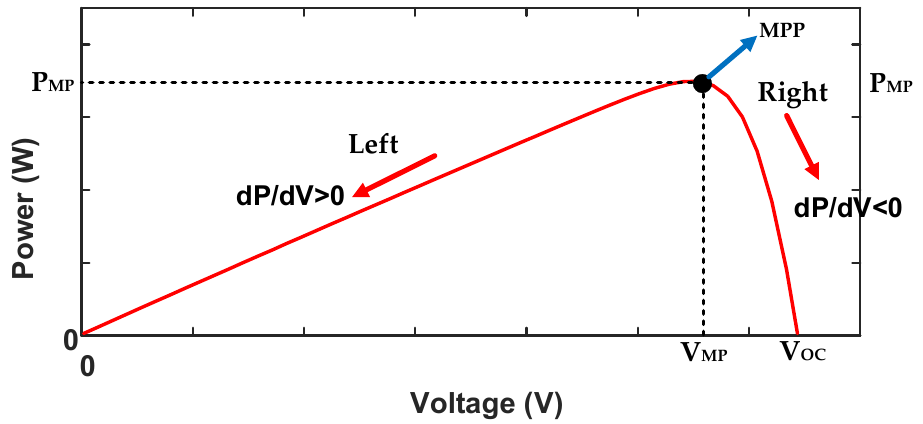
Figure 8. P-V curve with P&O operating principle. Figure 8. P ‐ V curve with P&O operating principle.